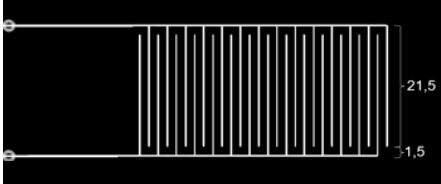
Figure 2. The designed dimensions of the printed IDC. Dimensions are in mm.